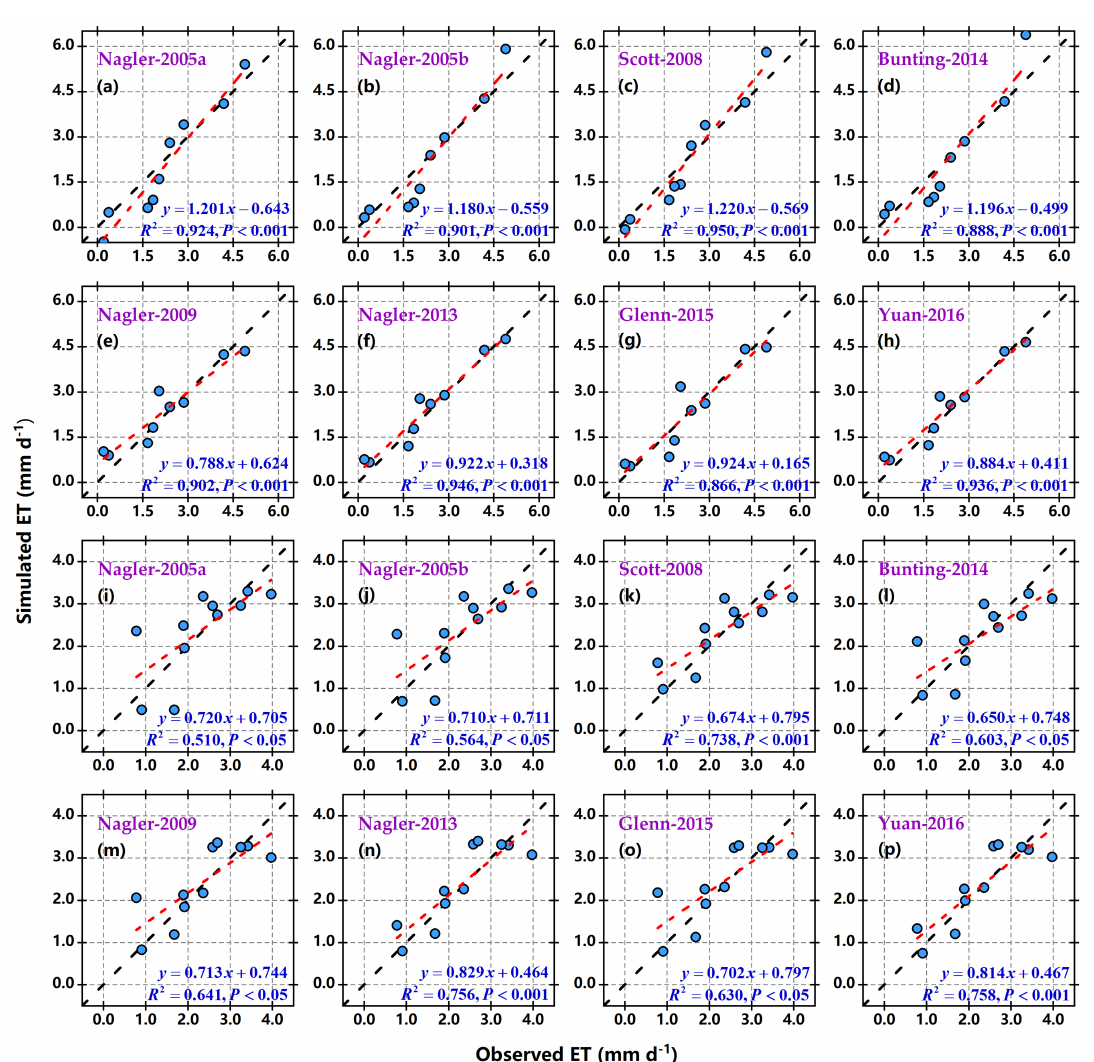
Figure 4. Observed ET versus simulated ET for the validation dataset of the Tamarix site ( a – h ) and the validation dataset of the Populus site ( i – p ). The red and black dashed lines are the regression lines and the 1:1 lines,